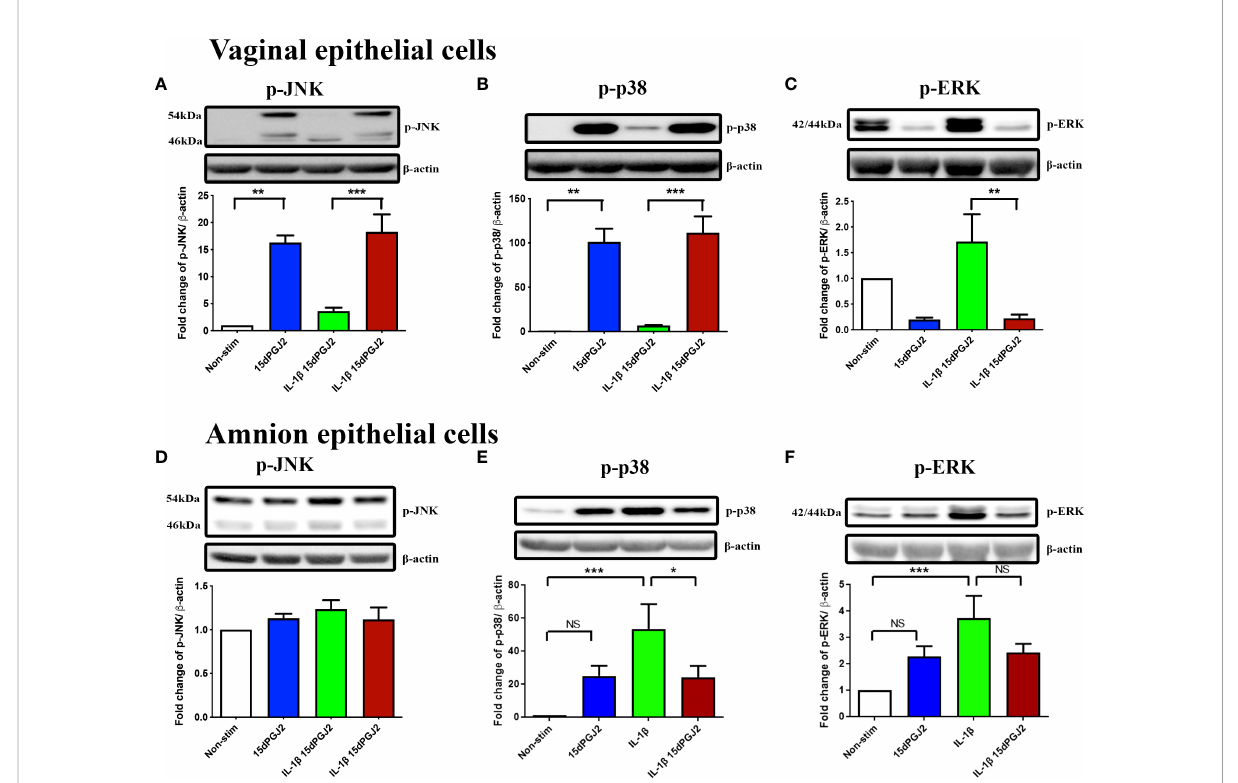
FIGURE 9 Effect of 15dPGJ2 MAPKs in vaginal and amnion epithelial cells. VECs and AECs were pre-incubated with 32 m M of 15dPGJ2 for 2 hours then stimulated with 1ng/ml of IL-1 b for 15 minutes. Whole cell lysate was used to determine, phosphorylated-JNK1/JNK2(Thr183/Tyr185), phosphorylated-p38(Thr180/Tyr182) and phosphorylated-ERK (Thr202/Tyr204) via Western immunoblotting. A representative blot was shown above each graph with b -actin as a loading control. In VECs, incubation with 15dPGJ2 alone for 2 hours signi fi cantly increased the basal level p-JNK ( p < 0.01) (A) and p-p38 ( p < 0.01) (B) but had no effect on p-ERK (C) . Treatment with 1ng/ml of IL-1 b increased p-ERK, and this was attenuated by pre-incubation with 15dPGJ2 ( p < 0.01) in VECs (C) . In AECs, no effect was seen on p-JNK with IL-1 b and/or 15dPGJ2 (D) . IL-1 b stimulation of AECs led to an increase in p-p-38 ( p < 0.001) (E) and p-ERK ( p < 0.001) (F) , the response of which were attenuated upon pre- incubation with 15dPGJ2. * p < 0.05, ** p < 0.01, *** p < 0.001, NS non signi fi cant. n = 3-6. Data are presented as mean ±